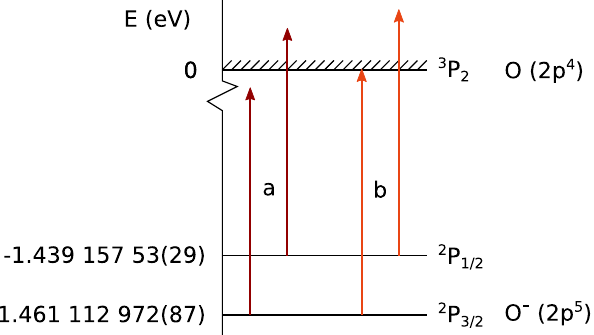
Fig. 1 | Energy levels of O − . The ground state has the electron con fi guration 1 s 2 2 s 2 2 p 52 P 3/2 . We measure binding energies of 1.461,112,972(87)eV and 1.43,915,753(29)eV for the 2 P 3/2 and 2 P 1/2 levels, respectively. The photon energy arrowslabeled"a"representthephotonenergyneededforphotodetachmentfrom the excited levelonly, whereasthearrows labeled"b"represent the photon energy neededtophotodetachfromboththegroundstateandexcitedstate.Thehatched